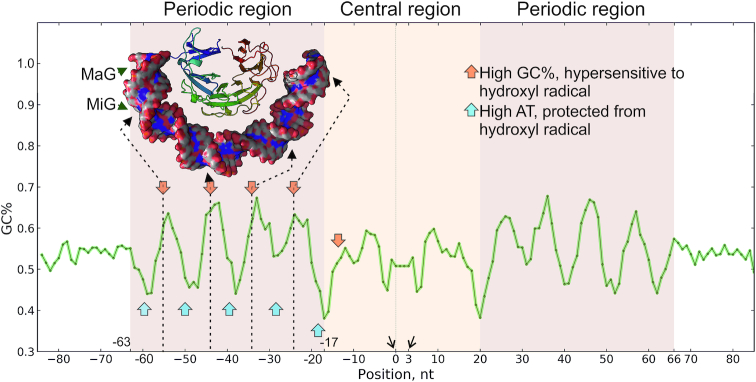
DNA gyrase binding motif reflects DNA wrapping around the CTDs. DNA gyrase ‘combined’ motif (based on datasets from all three different antibiotics tested) flanked with random regions shown in green. Orange arrows indicate GC-rich and hydroxyl radical hypersensitive sites, blue arrows—AT-rich and protected regions. The structure of DNA-wrapped CTD is shown above the motif, dashed arrows point hypersensitive sites in DNA’s minor groove. MaG—DNA major groove, MiG—DNA minor groove. Hydroxyl radical sensitivity data is taken from (91).